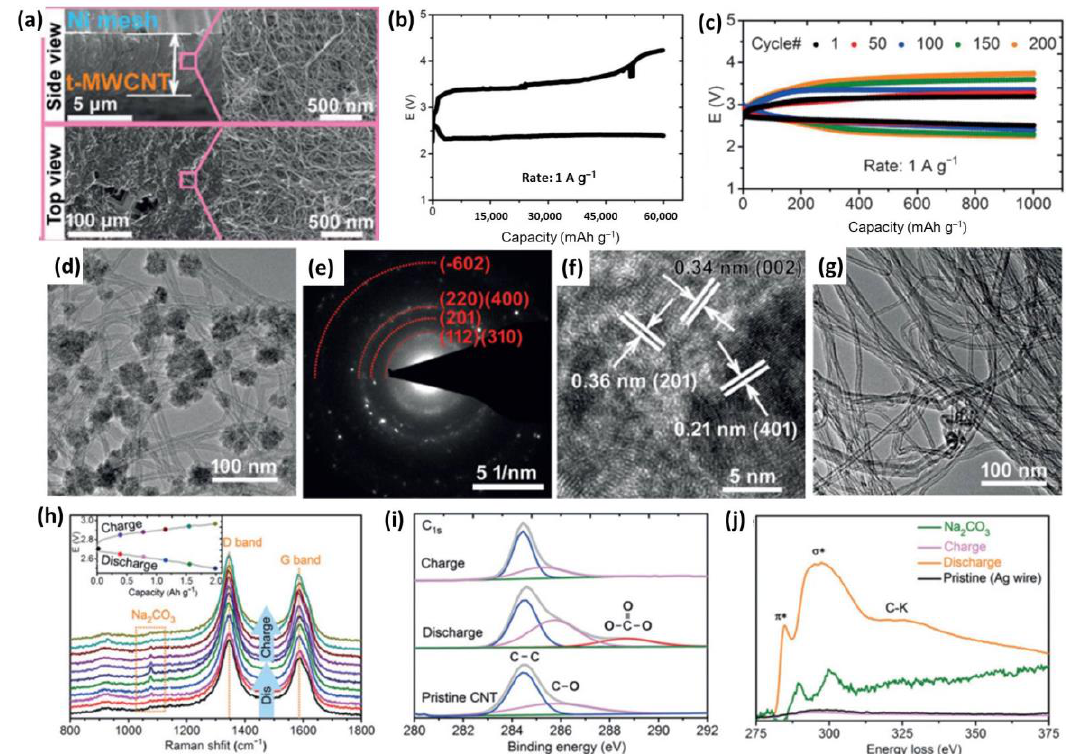
Figure 4. ( a ) SEM images of the t-MWCNT cathode from top and side views for the room temperature Na-CO 2 batteries; ( b ) Full discharge/charge curves at 1 A g −1 ; ( c ) Discharge and charge profiles at 1 A g −1 ; ( d ) TEM image, ( e ) SAED image, and ( f ) HRTEM image of t-MWCNT cathode after discharge for 4 h at 1 A h −1 ; ( g ) TEM image of charge state of t-MCNT cathode; ( h ) In situ Raman spectrum and corresponding discharge/charge profiles with 11 selective points; ( i ) XPS and ( j ) EELS of Ag wire cathode at different states. Reproduced with permission from [37]. Copyright 2016, Wiley-VCH.